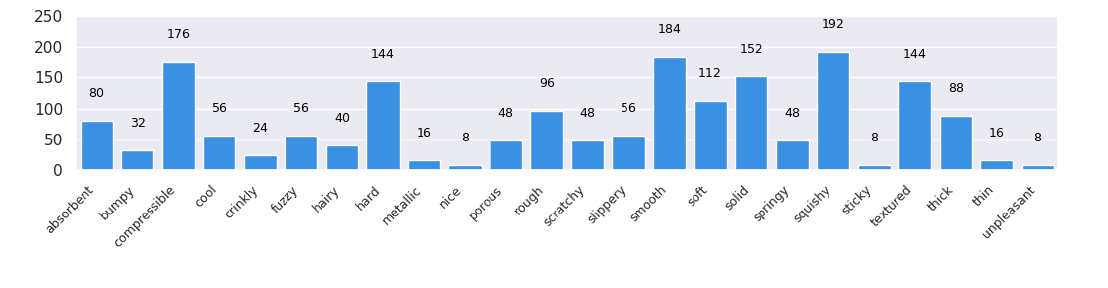
Figure 2. Occurrences of each adjective in the Penn Haptic Adjective Corpus 2 (PHAC-2)